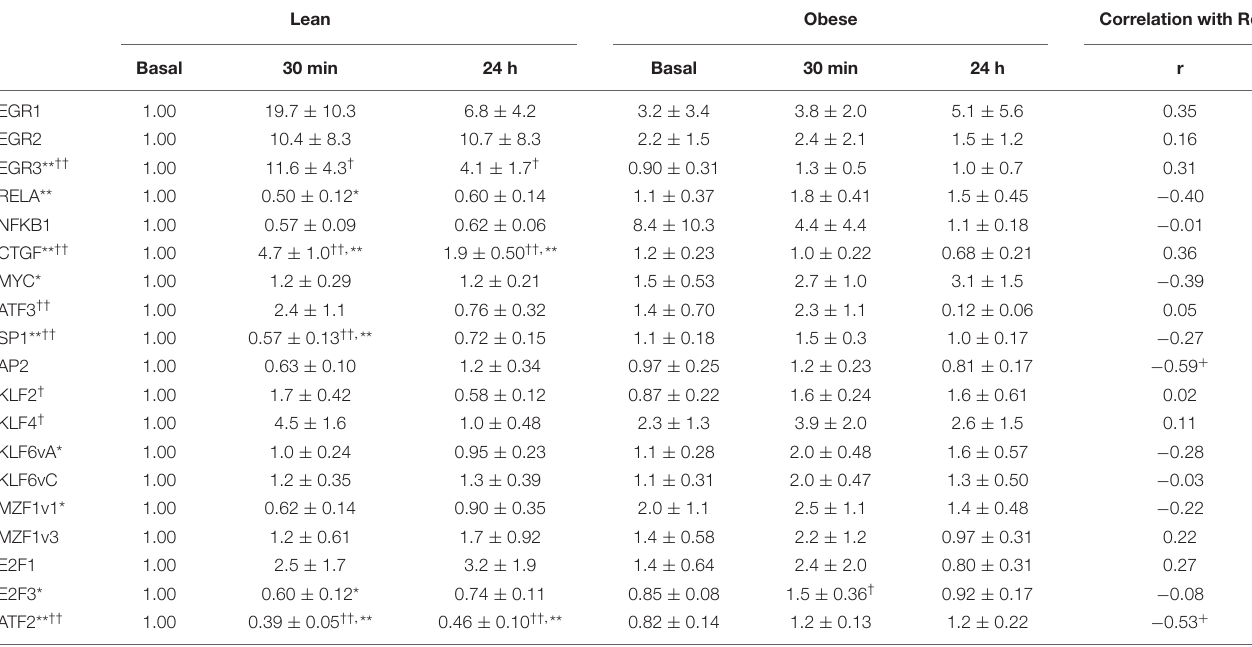
TABLE 4 | Acute effect of exercise on mRNA expression of transcription factors. Lean Obese Correlation with Rd Basal 30 min 24 h